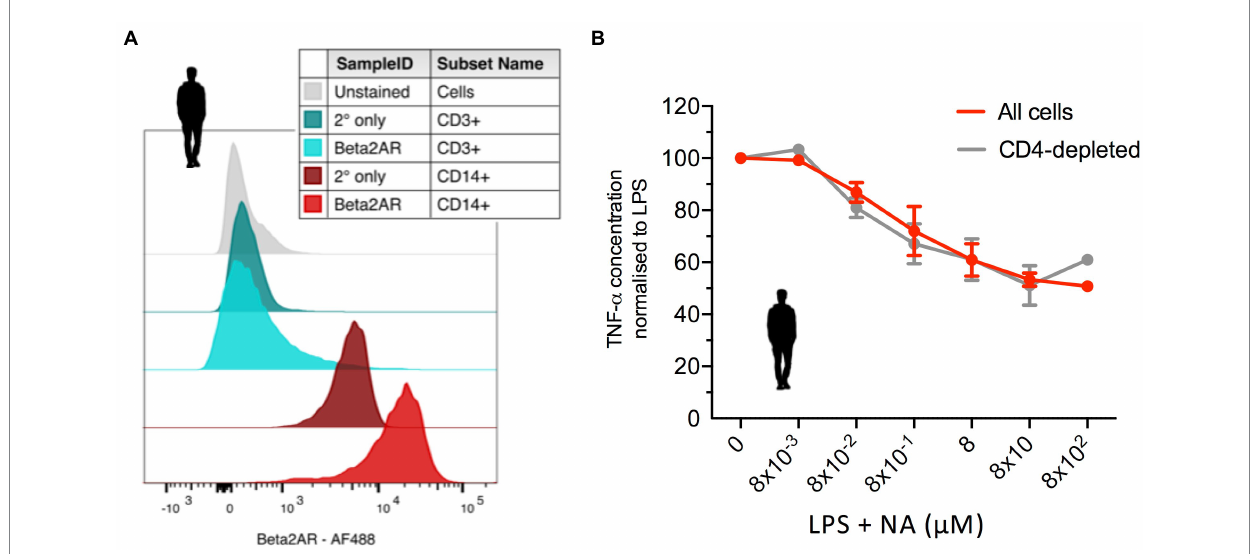
FIGURE 5 NA promotes TNF suppression via β 2 -AR and is independent of T-cells in humans. (A) Flow cytometry data showing the expression of β 2 -AR in different populations (CD14 + and CD3 + ) of human splenocytes. Secondary antibody alone is shown for each cell types. (B) Dose dependent change of LPS- induced TNF caused by treatment of human peripheral blood cells with different concentrations of NA (8 × 10 − 5 – 8 × 10 2 μ M), either in mixed cell culture (all cells) or culture depleted from CD4+ cells. Data are expressed as % over LPS control ( n = 4). All data are expressed as mean ±